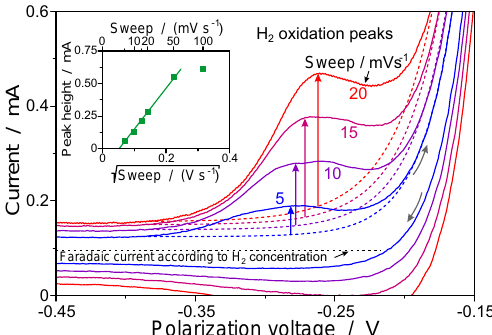
Figure 3. Voltammograms about the variation of the cell tempera- ture; measuring gas: 40vol.ppm O 2 in N 2 ; gas flow rate: 10sccm; electrode size: 0.75cm 2 ; open-circuit potential: − 150mV (550 ◦ C) to − 200mV (800 ◦ C); potential scan rate: 1Vs − 1 ; start potential: − 0 . 17V; the second cycle is shown.